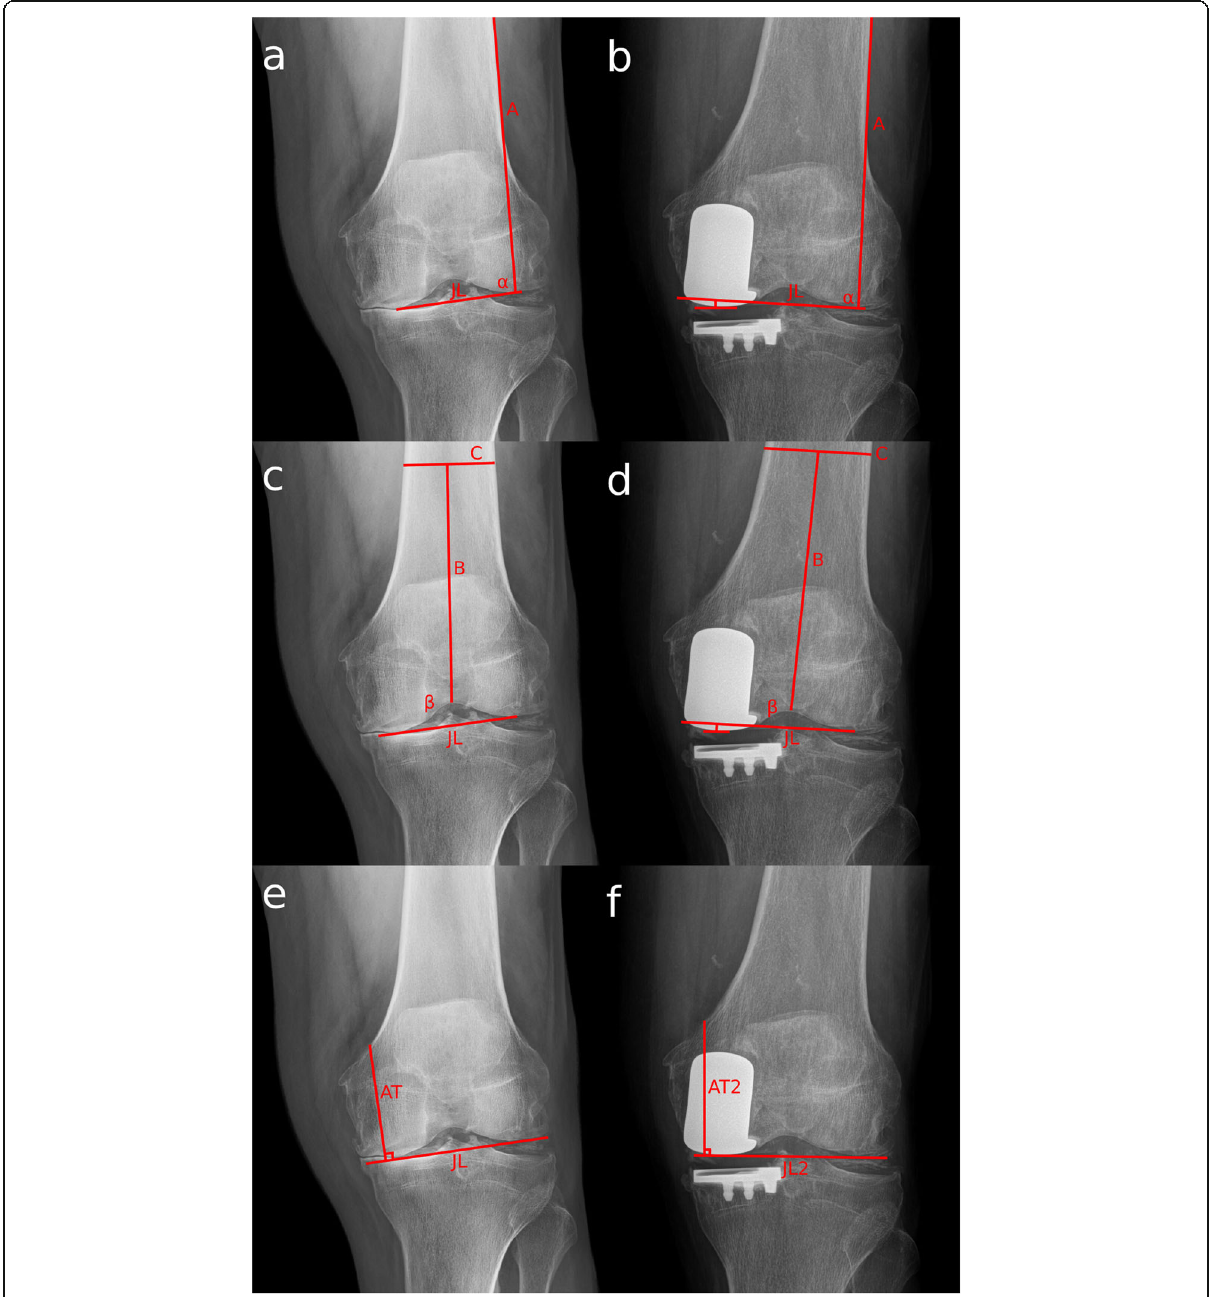
Fig. 1 Anteroposterior Knee X-rays of a left knee showing the different joint line measure techniques. In the Weber 1 method, the angle (alpha) between a line that goes through the most distal point of both femoral condyles (JL) and the lateral femoral cortex ( a ) is obtained in the pre- operative x ray ( a ). Then (alpha) is reproduced in the post-operative x ray ( b ) with the lateral femoral cortex and the non-operative femoral condyle as reference. The variation in joint line is then measured. In the Weber 2 method the angle (beta) is obtained in the pre-operative x ray ( c ) between a line that goes through the most distal point of both femoral condyles (JL) and the line B that goes from the most proximal point of the intercondylar notch and the center of a line 10 cm proximal to it ( c ). Then the angle is reproduced in the post-operative x ray ( d ) with line B and the non-operative condyle as reference. The variation in joint line is then measured. In the Iacono method, the distance (AT) between the most proximal point of the Adductor Tubercle perpendicular to a line that goes through the most distal point of both femoral condyles (JL) ( e ) is compared to the same distance in the post-operative x ray ( f ). The difference between both is the variation in joint